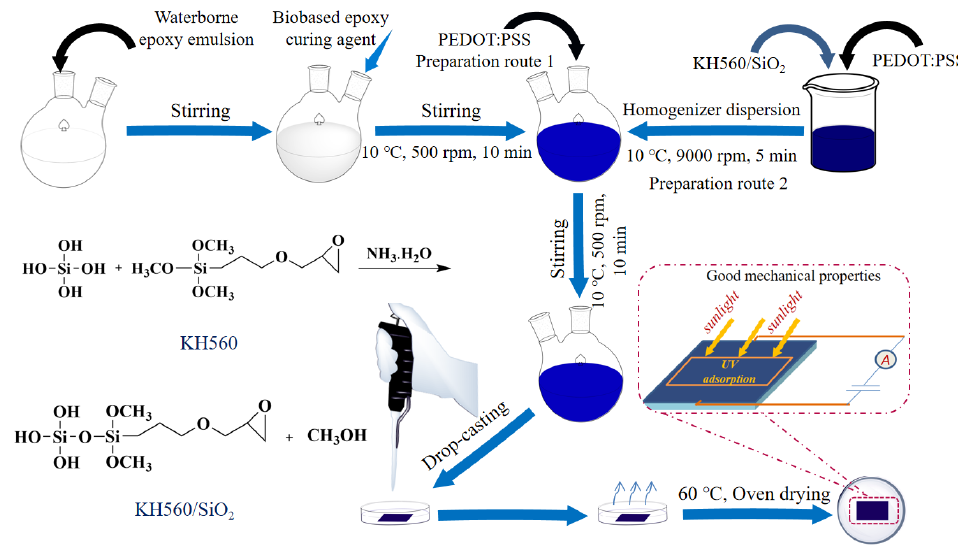
Figure 1. Schematic illustration of the preparation process of PEDOT:PSS/epoxy (route 1) and PEDOT:PSS/epoxy/(KH560/SiO 2 ) (route 2) aqueous dispersions, coatings, and the synthetic route of KH560/SiO 2